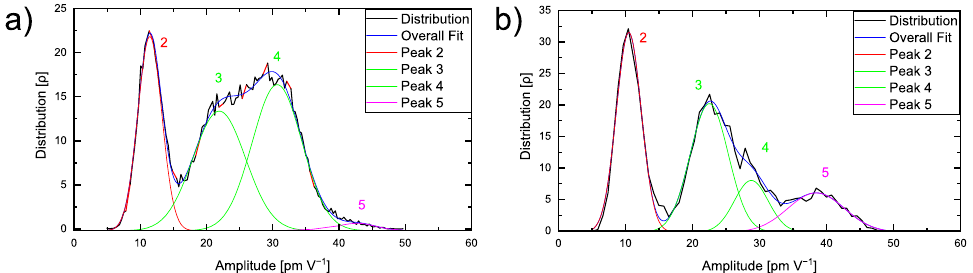
− LiTFSI with 50wt.% LLZO:Ta 6